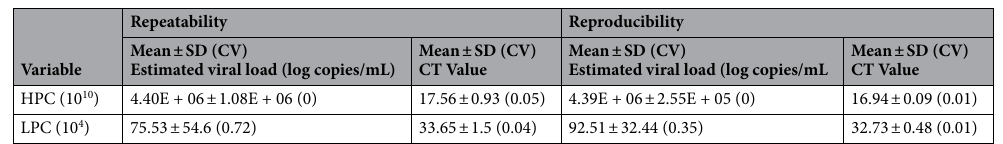
Table 3. Repeatability and reproducibility analysis of HPC and LPC according to estimated viral load and CT obtained from qPCR in DBS samples. HPC high positive control, LPC low positive control, SD standard deviation, CV coefficient of variation.